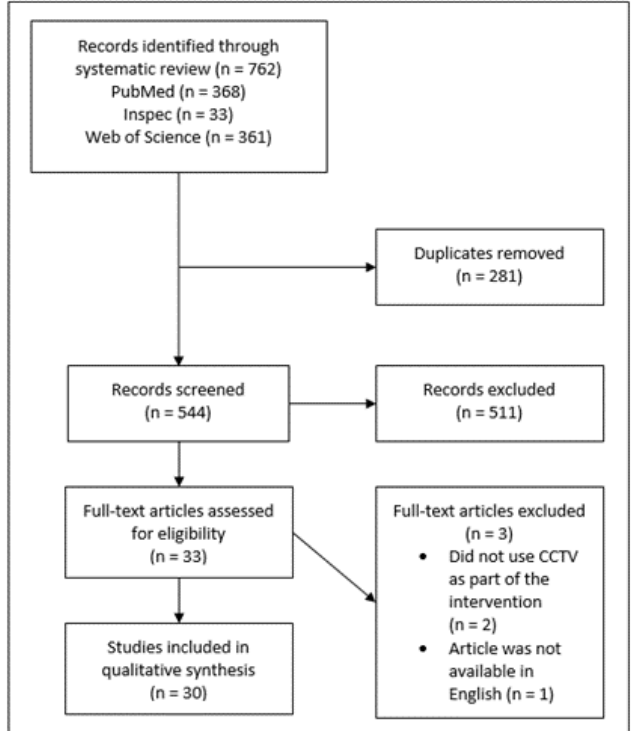
Figure 1. Flowchart of Study